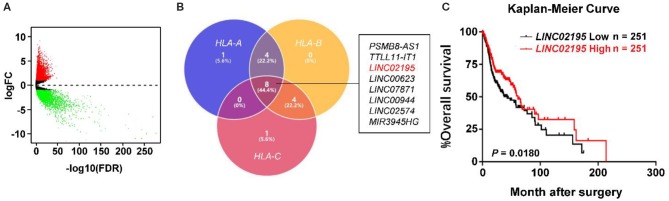
LINC02195 expression was closely correlated with MHC I molecules in the TCGA database. (A) Volcano plot of the differentially expressed lncRNAs between HNSCC tissues and adjacent tissues. The log2(fold change) on the X axis and—log10(P-value) on the Y axis are shown in the graph. Red dots represent high expression, and green dots represent low expression. Black shows lncRNA expression with both logFC < 1 and – log10 (P-value) < 0.05. Differentially expressed mRNAs and lncRNAs were calculated using edgeR, which identified upregulated overexpressed lncRNAs and 3,397 downregulated lncRNAs. (B) Venn diagram showing that eight DElncRNAs simultaneously associated with HLA-A, HLA-B, and HLA-C. (C) Kaplan-Meier survival curve of patients stratified according to low and high expression of LINC02195 in the TCGA database (HNSCC). The median expression was used as the cut-off; P = 0.0180.